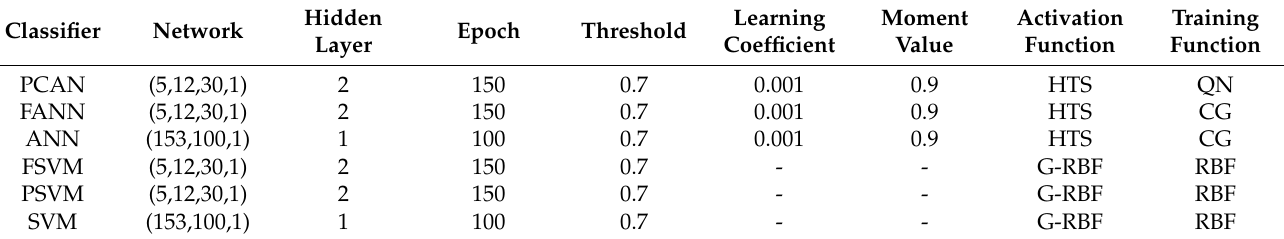
Table 7. Hyper-parameters procedure for all used classifiers.